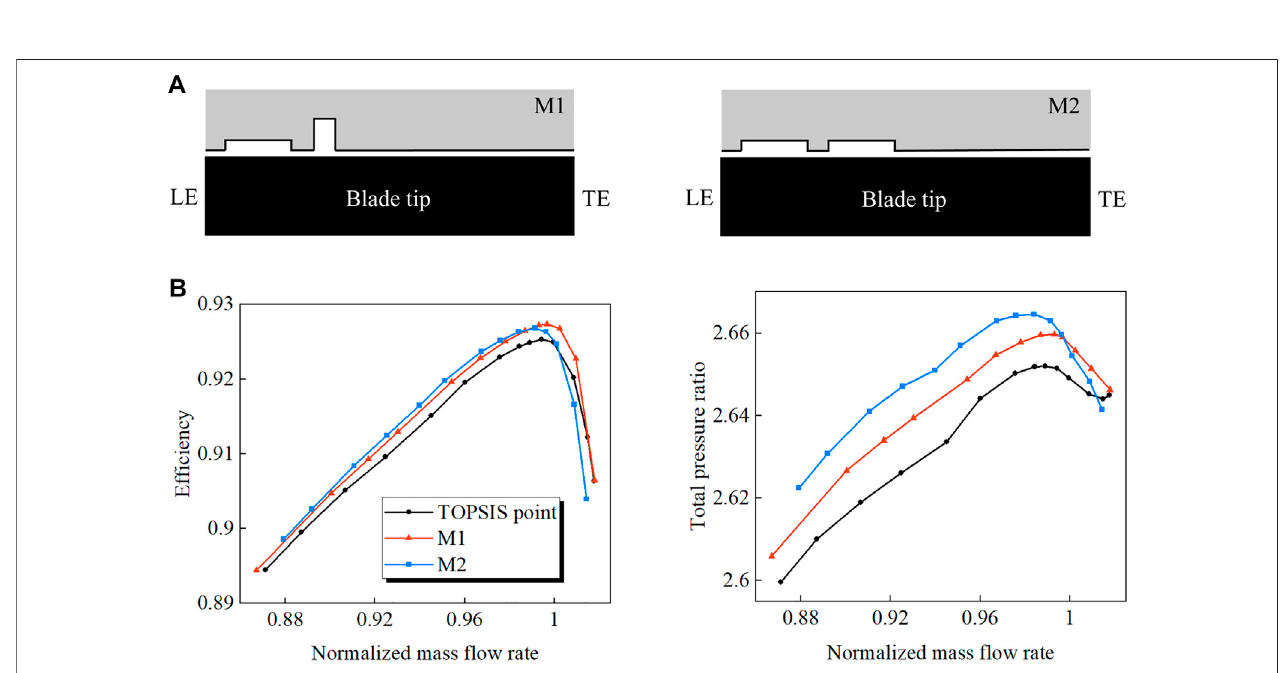
FIGURE 15 | Schematic diagram and characteristic lines of the multiple-groove casing treatments. (A) Groove schematic (B) Characteristic lines.